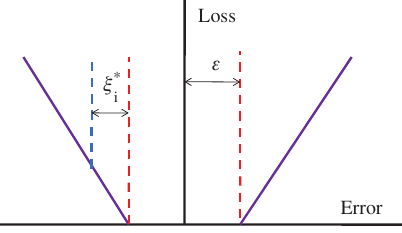
Figure 3: Vapnik’s ε -Insensitive Loss